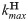
The heat maps which show the correlation (a) between k
G and s
H (a), and (b) between k
G and kmaxH.The color scale corresponds to the log-frequency of occurrence. The Pearson correlation coefficients for log(k
G) vs. log(s
H) and for log(k
G) vs. log(kmaxH) are 0.92 and 0.91, respectively. The pink lines show the curves on their means along vertical values, and the blue dashed line in (a) shows the fitting power function with slope 1.14.